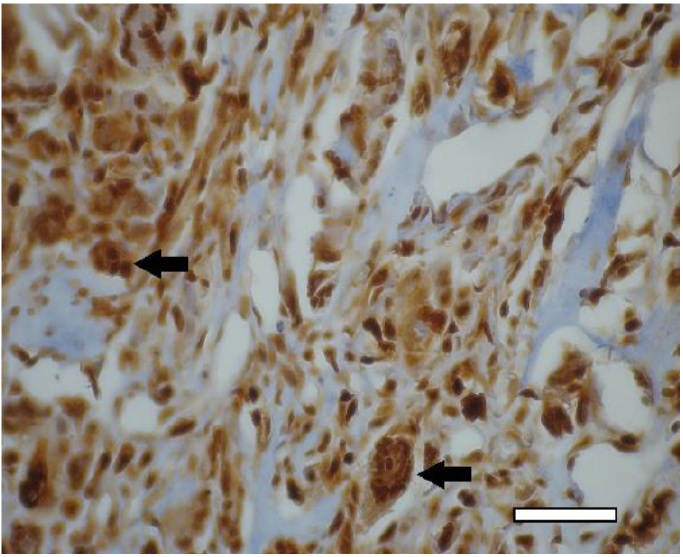
Figure 21. 3rd group (dECM and MSC), 2 weeks. Immunohistochemical staining (PCNA) of multinu- cleated cells of cartilage tissue resorption (arrows), objective lens × 40, scale bar—50 µ